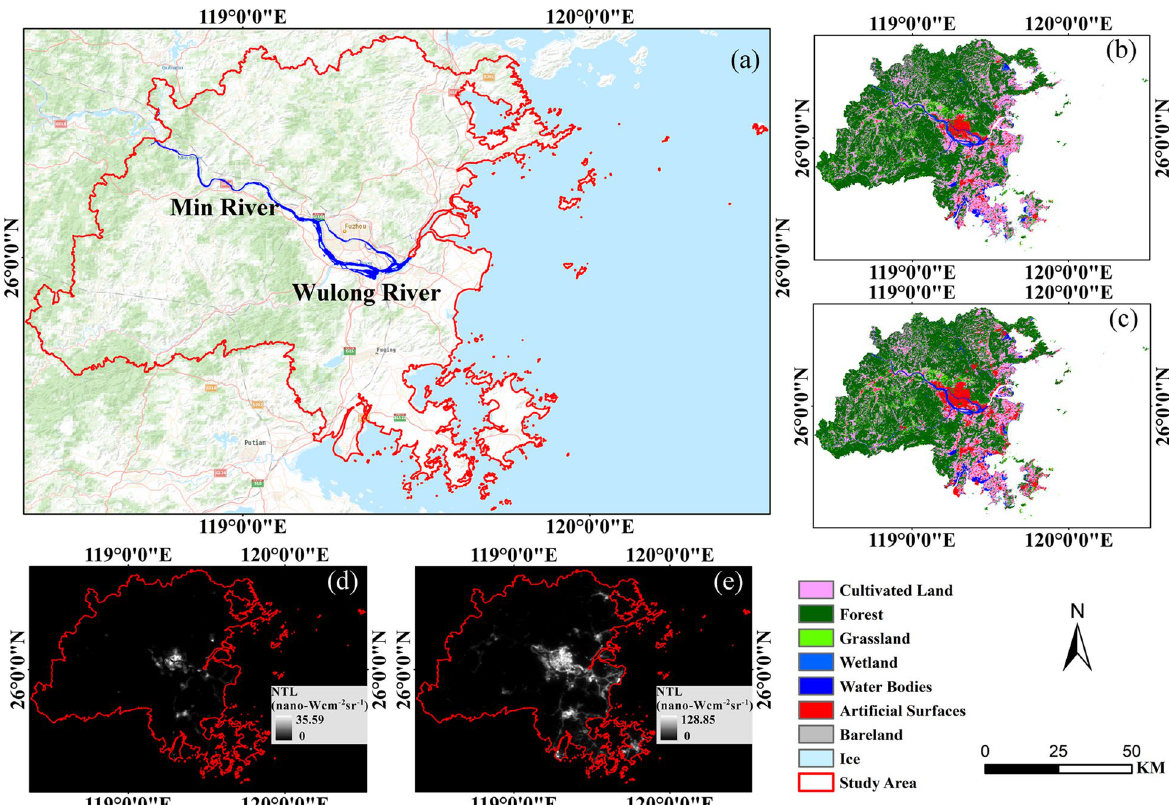
Fig. 1 Study area and datasets: ( a ) Location of Fuzhou, Land cover map of ( b ) 2010 and ( c ) 2020 and NTL map of ( d ) 2010 and ( e )